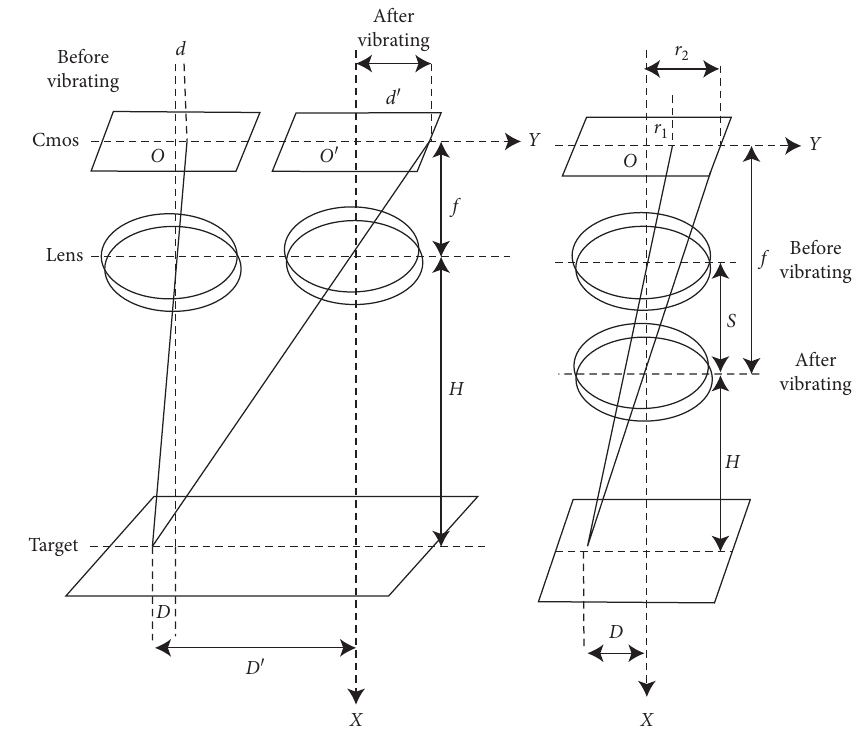
Figure 2: Image shift of UAV system along the OY , OX axes.